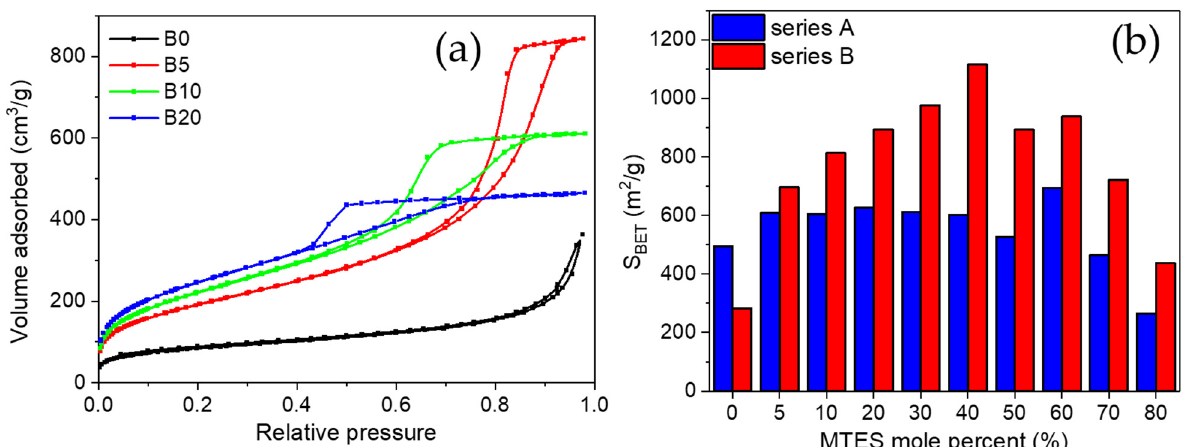
Figure 2. ( a ) Evolution of low-temperature nitrogen adsorption/desorption isotherms with MTES content. ( b ) Comparison between the apparent surface area evolution with the MTES mole percent and the acid catalysts content (series A and series B labels represent the pH = 2.0 and pH = 4.5).